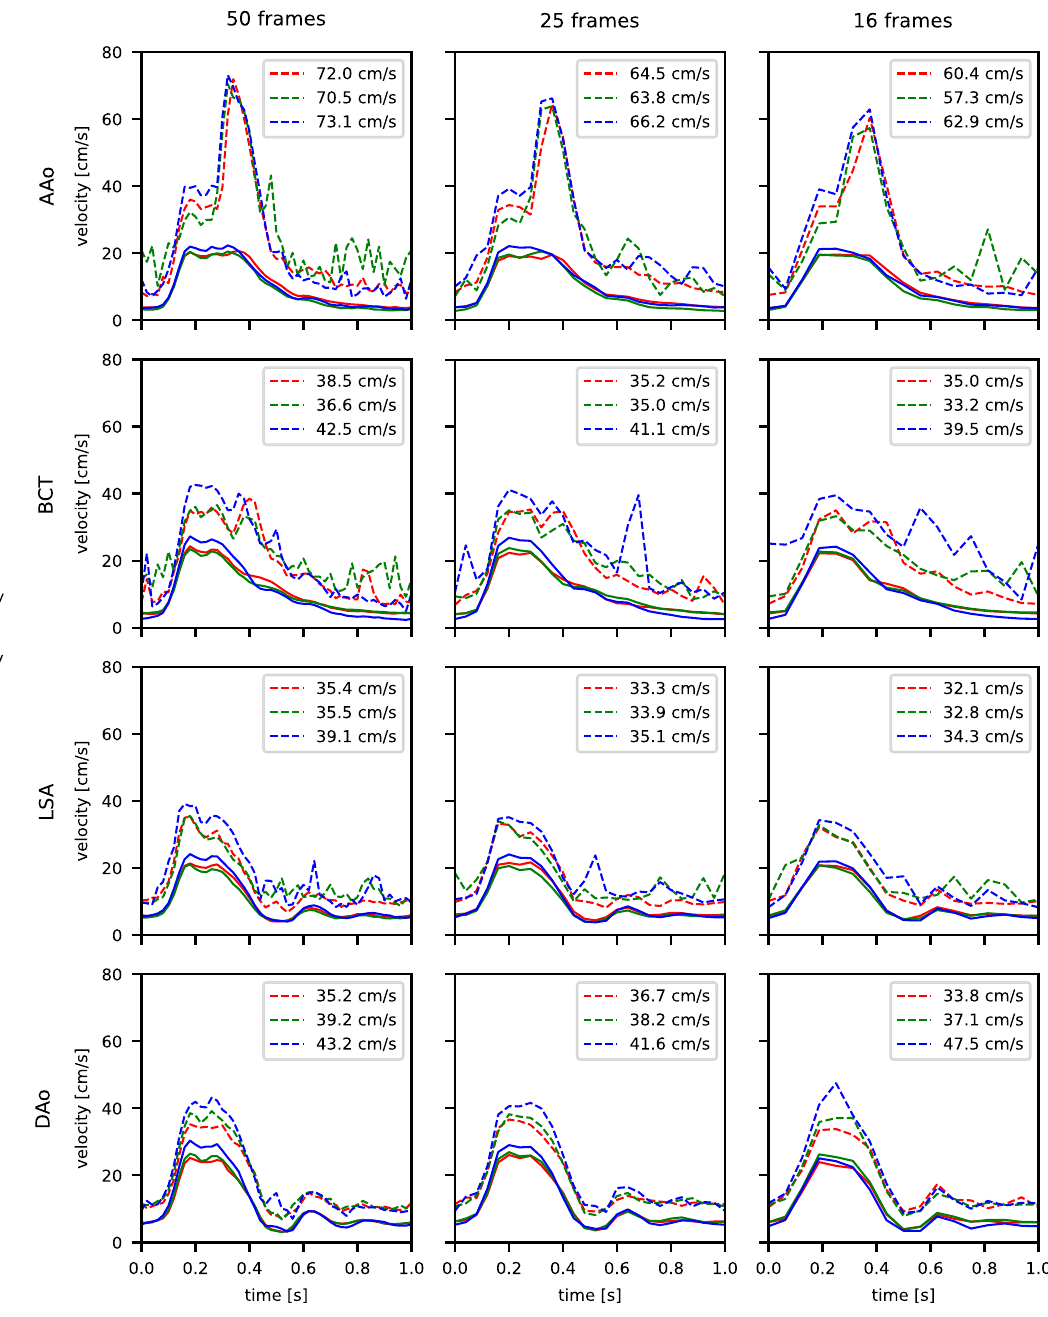
Figure 5. 4D-flow cross-sectional mean (solid) and maximum (dashed) velocity at four landmarks (Fig. 1g) and three different temporal sampling rates. Highest peak-systolic velocities (see values in legends) were measured in model M r (blue); and inter-model peak-systolic velocity differences were greater at landmarks further downstream. The temporal sampling rate impacted the measurement of peak velocities, which was most pronounced at AAo point. Spikes in diastole were attributed to noise in near-boundary pixels and inaccurate contouring. Plots created using Python (v3.6, https:// www. python.